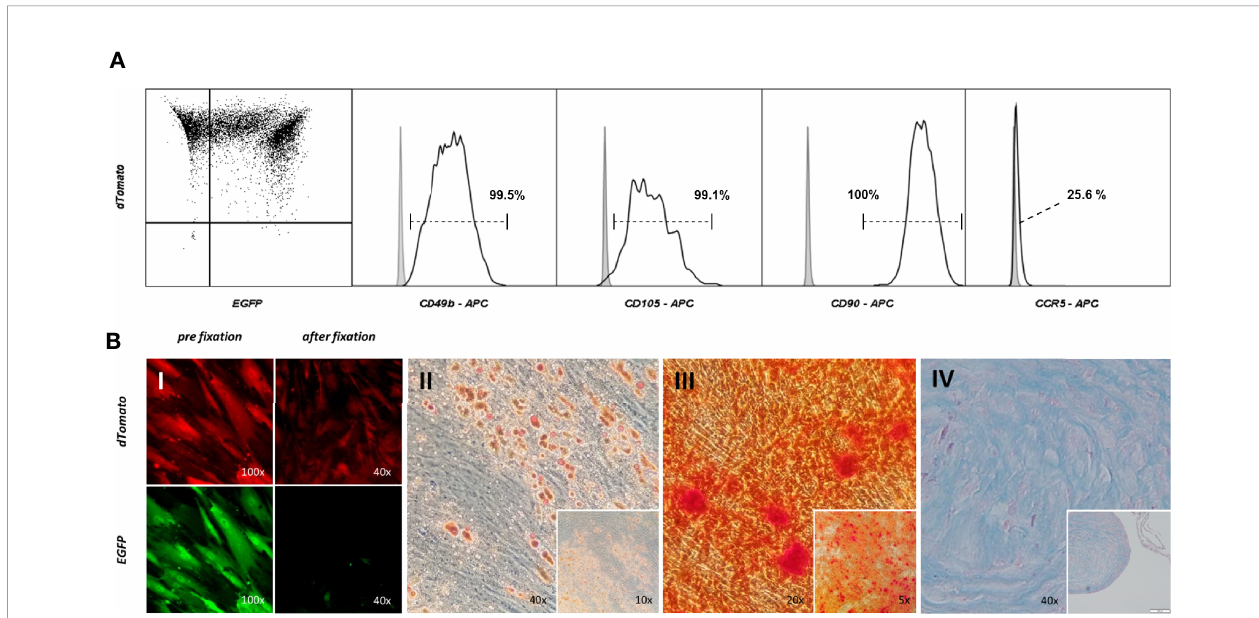
FIGURE 6 | Targeting – selecting ASCs leaves regenerative potential unaltered. (A) Immunophenotypic analysis of cell surface pro fi le of double positive ASCs. Cells were stained with fl uorescent marker labeled antibodies for CD90, CD49b, CD105 and CCR5. The gray fi lled graph represents the signal of an unstained control, the black line the population stained with the corresponding antibody. (B) Multilineage differentiation Assay. Double positive ASCs were capable of adipo- (II), osteo- (III) and chondrogenic (IV) differentiation. Cells were checked for the correct fl uorescent expression pattern. EGFP was washed out during formaldehyde fi xation